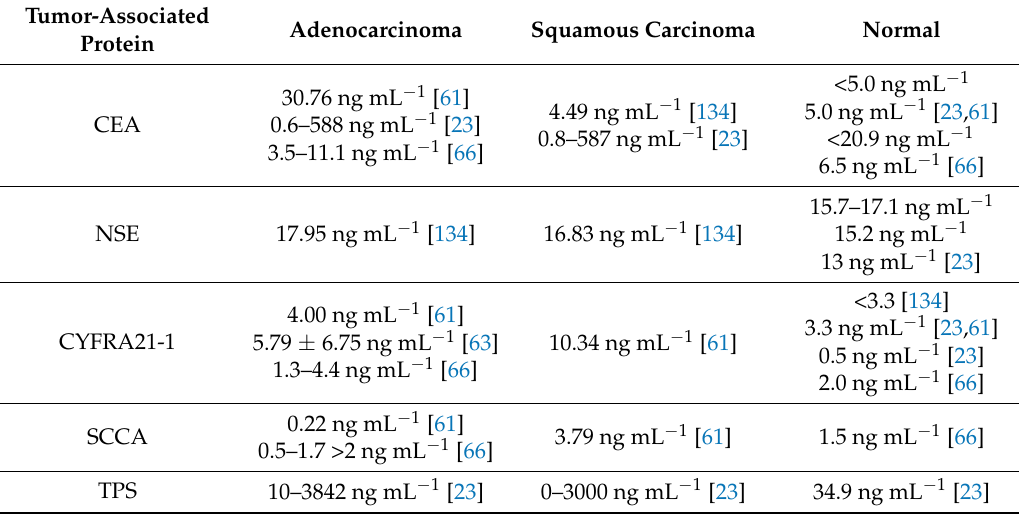
Table 5. Comparative levels of well-known lung cancer biomarkers in blood plasma of patients with adenocarcinoma and squamous lung cancer and healthy people.